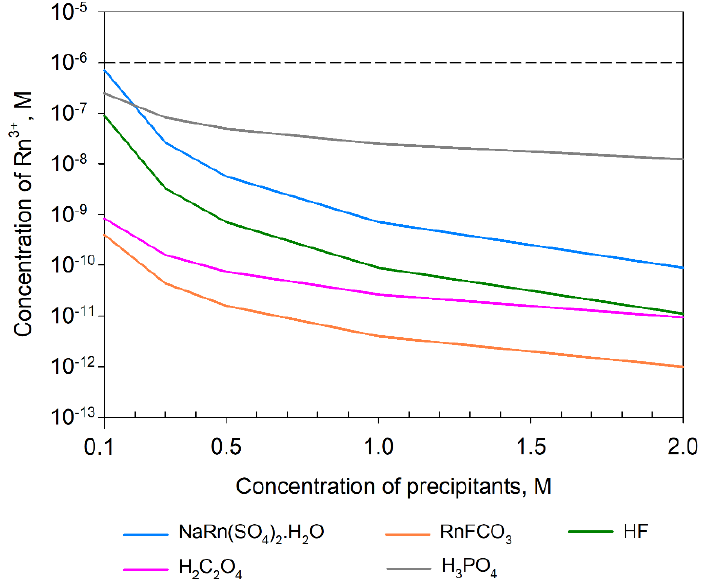
Figure 14. Equilibrium concentrations of Rn 3+ for precipitation into NaRn(SO 4 ) 2 · H 2 O at pH 1, and the results are compared with those of fluoride, fluoro-carbonate, oxalate, and phosphate (dashed line: 1 ppm line). Table 9. Precipitation equations Rn 3+ for precipitation into NaRn(SO 4 ) 2 H 2 O at pH 1 and the results are compared with fluoride, fluoro-carbonate, oxalate, and phosphate (equations used in Figure 14).